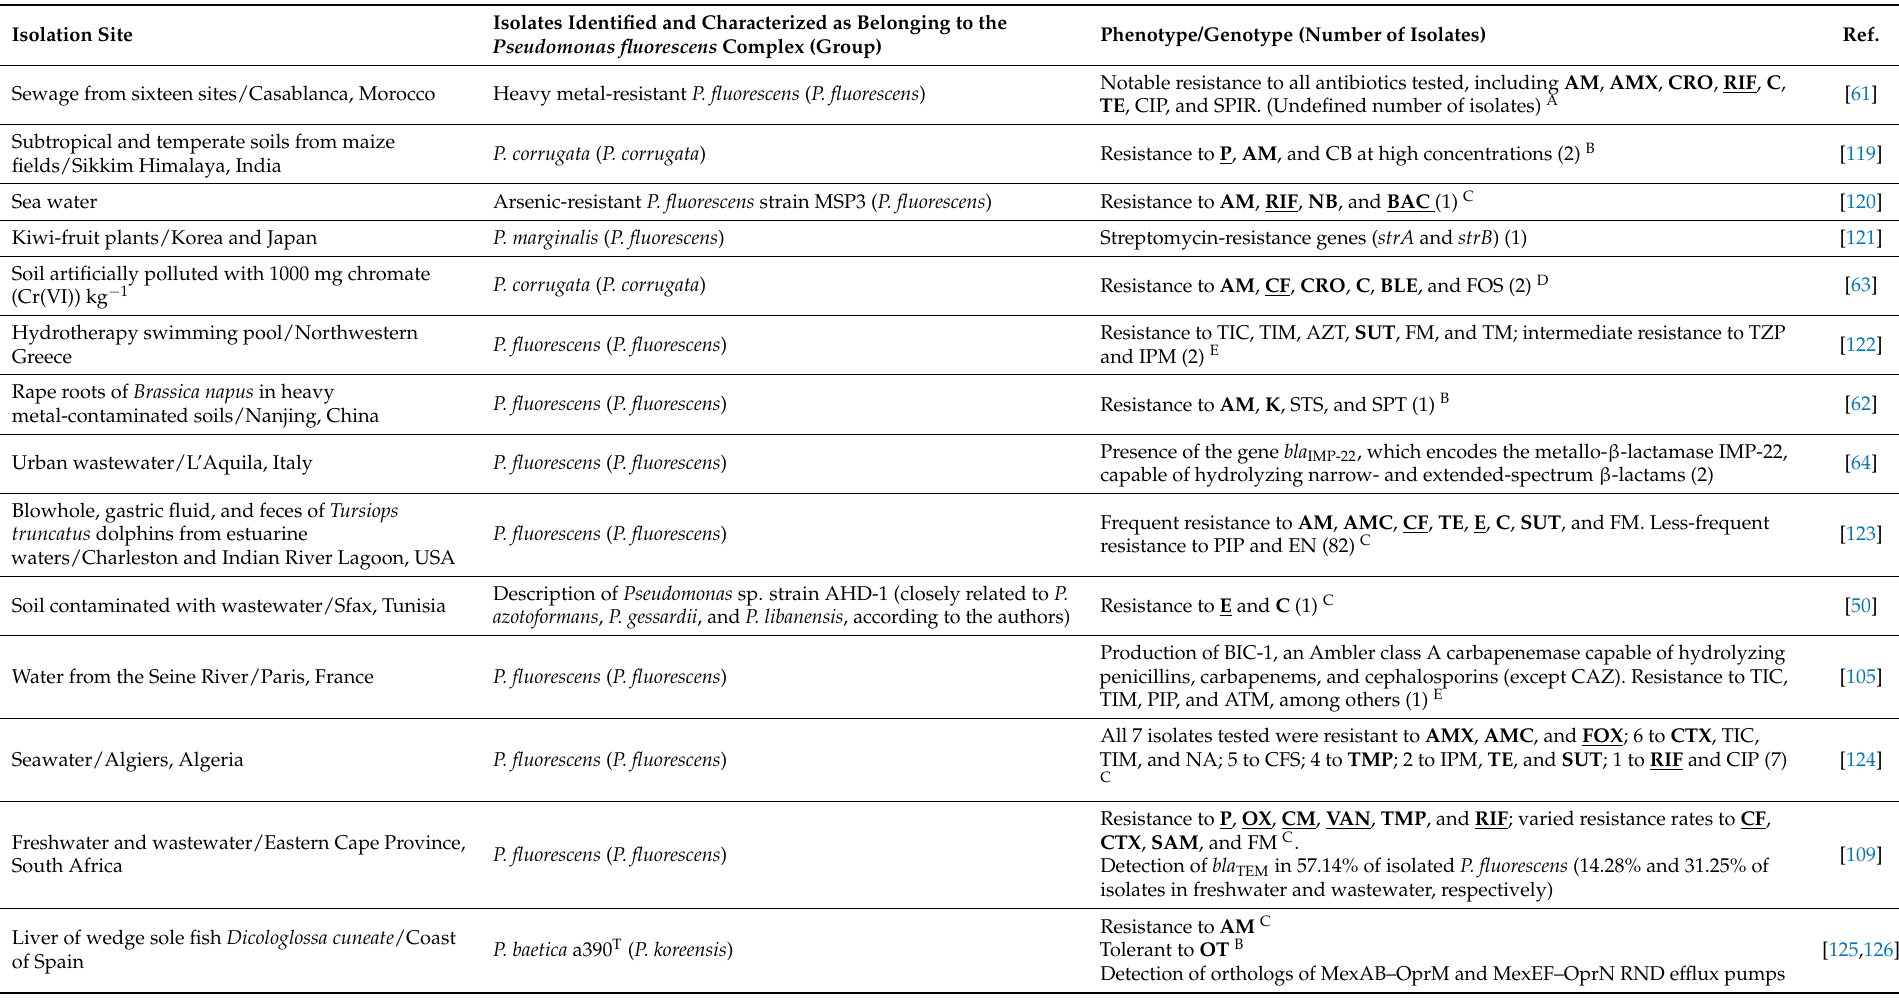
Table 2. Isolates of the Pseudomonas fluorescens complex obtained from human-impacted or metal-polluted environments and their resistance